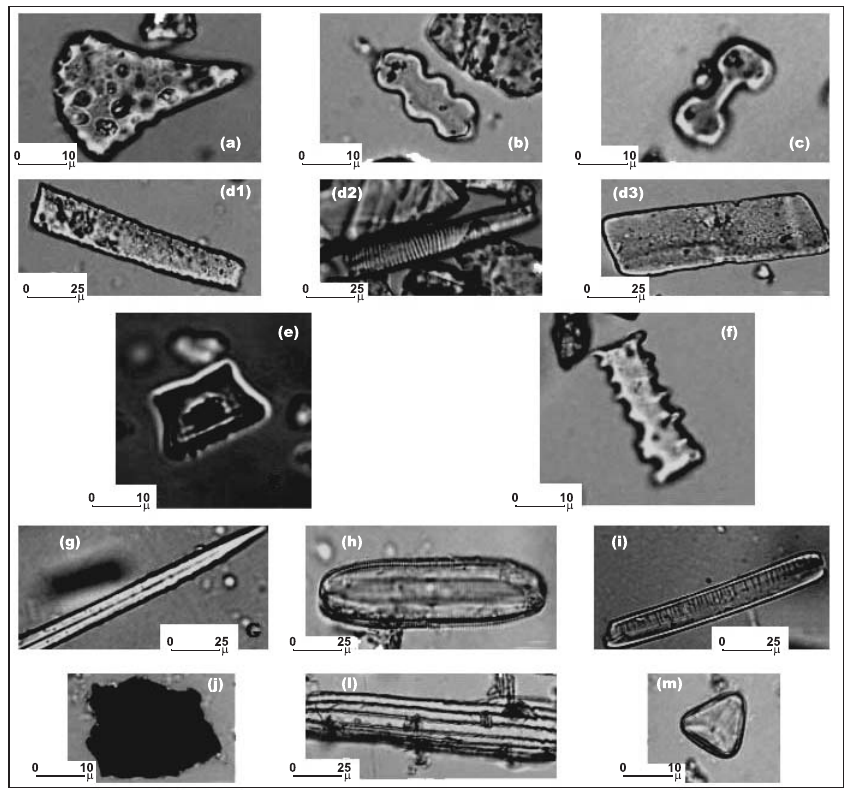
Figura 1. Fotomicrografias de morfotipos de corpos silicosos (fitólitos, espículas de esponjas e diatomáceas) encontrados na fração silte em horizontes superficiais de solos de diferentes ecossistemas: Fitólitos: (a) buliforme; (b) trilobado; (c) halter; (d1, 2 e 3) bastonetes; (e) sela ou rondele; (f) bastonete serrilhado; (g) espícula de esponja; (h) diatomácea elíptica; (i) diatomácea retangular; (j) corpo silicoso perfurado; (l) tecido silificado; (m) grão de